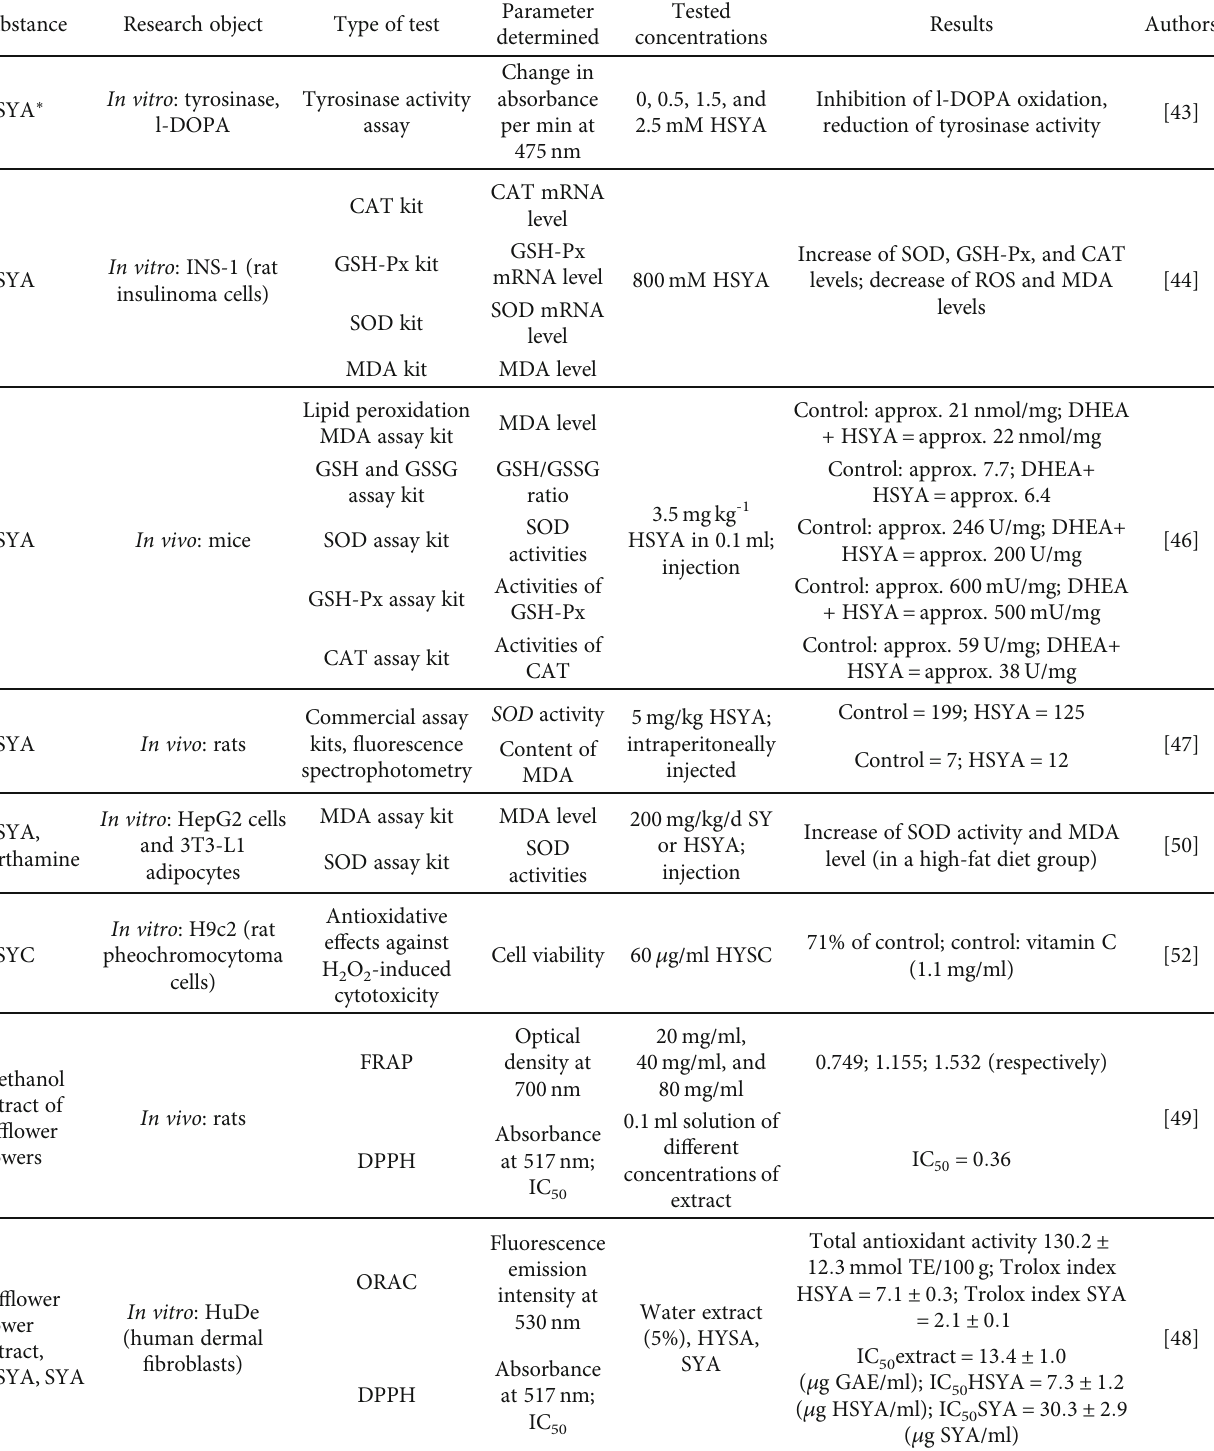
Table 2: Selected studies of antioxidant activity of substances present in sa ffl ower fl owers.